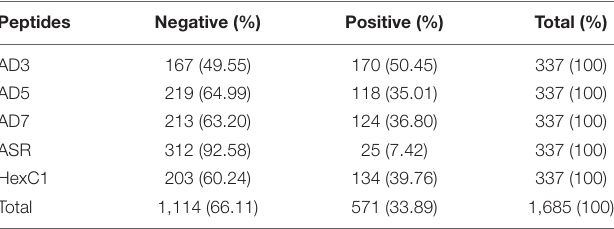
TABLE 6 | Human serum reaction with adenoviral antigen peptides.